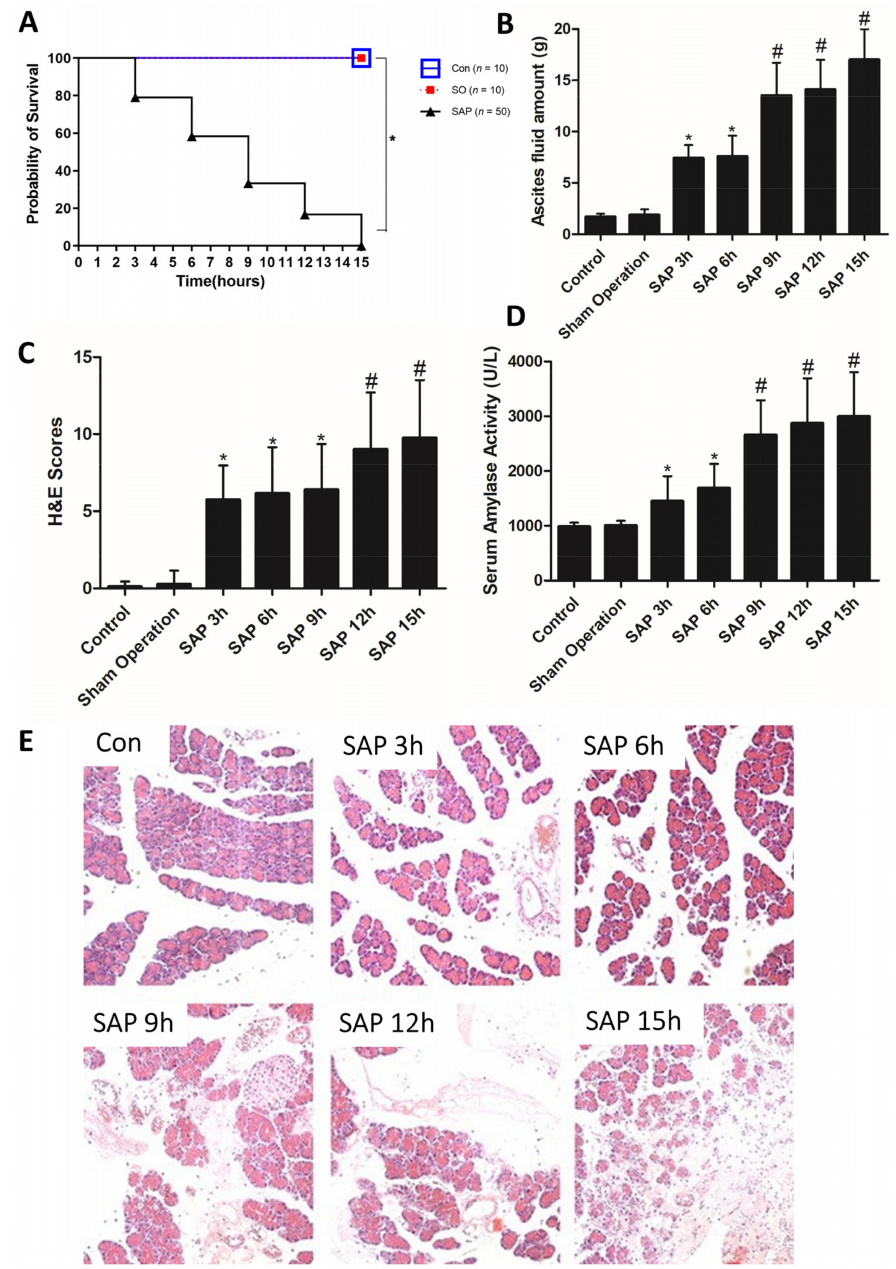
Figure 1. Mortality, pancreatic injury and amylase activity that showed significant differences between groups. ( A ) The mortality of severe acute pancreatitis (SAP) rats at 3, 6, 9, 12 and 15 h. ( B ) Ascites fluid amount at 3, 6, 9, 12 and 15 h of SAP rats. ( C ) Histopathological scores were evaluated complying with the standardized scoring system described in the Materials and Methods. ( D ) Serum amylase activity in different groups. ( E ) Histopathological structure of pancreas (H&E, × 100). * p < 0.05 versus the sham operation (SO) group; # p < 0.05 versus the SAP 3 h group; Con: